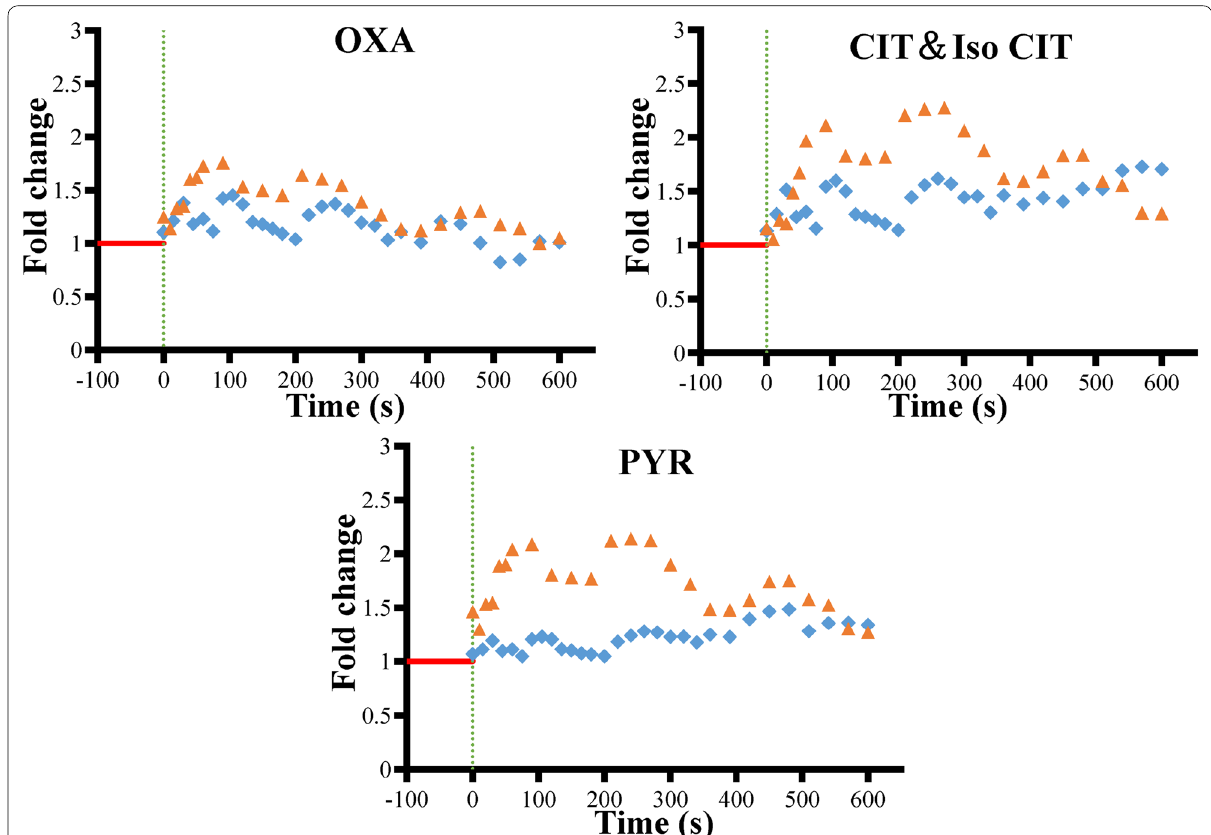
Fig. 4 Changes of extracellular organic acids during the first 10 min after the glucose pulses. Fold changes of OXA, CIT&Iso-CIT and PYR of the 0.90 g/L glucose pulse experiment (closed lozenges) and 0.11 g/L glucose pulse experiment (closed triangles). Vertical hashed lines represent the start of the glucose pulse. The steady-state level is represented as red horizontal